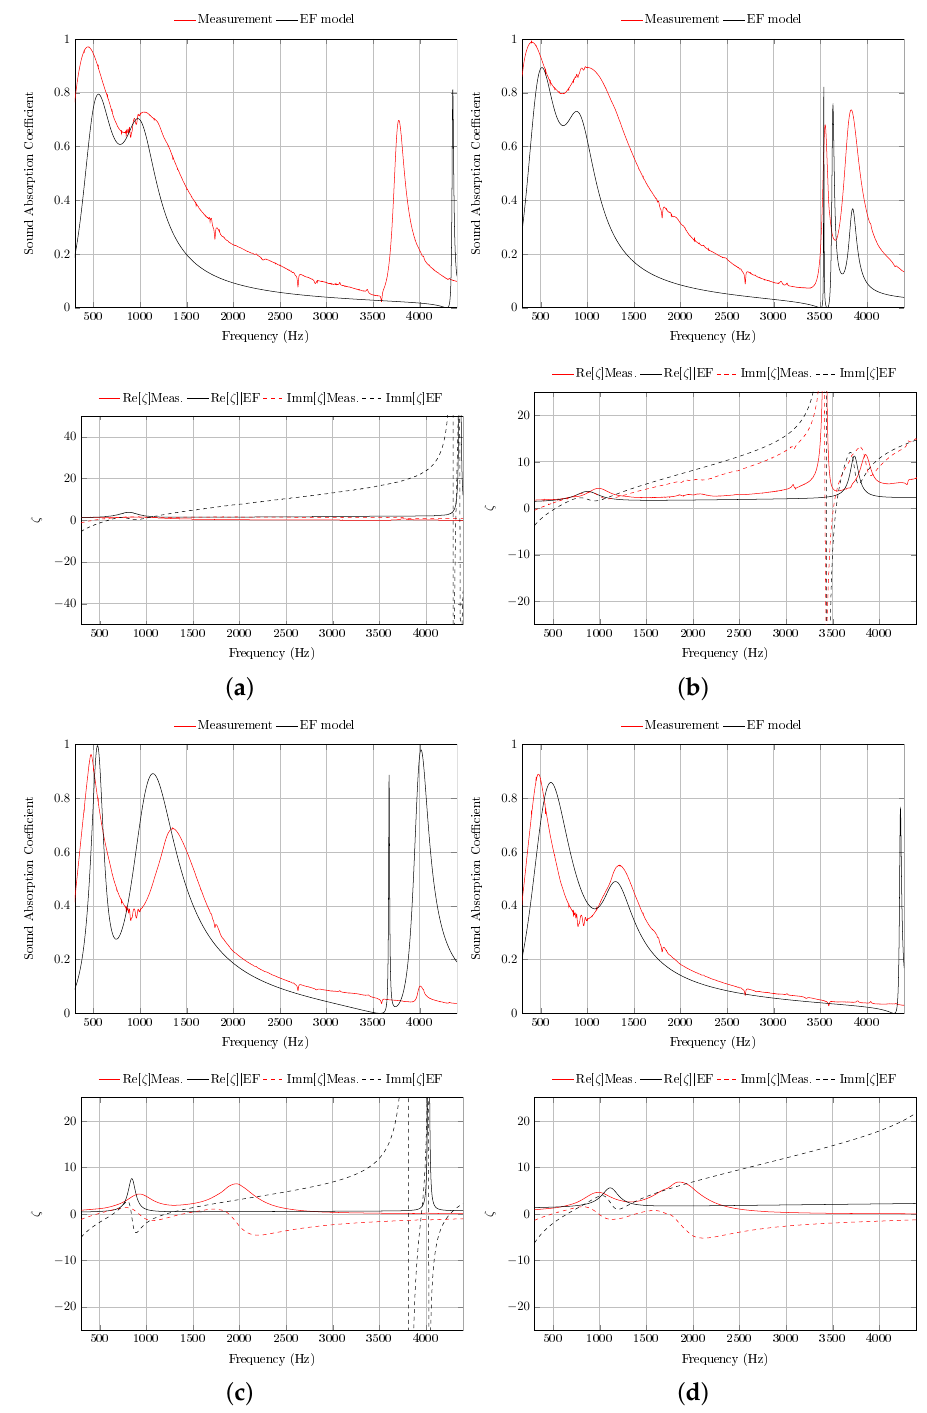
Figure 12. Sound absorption coefficient and normalized surface impedance for four DL configura- tions. ( a ) Configuration A. ( b ) Configuration B. ( c ) Configuration C. ( d ) Configuration